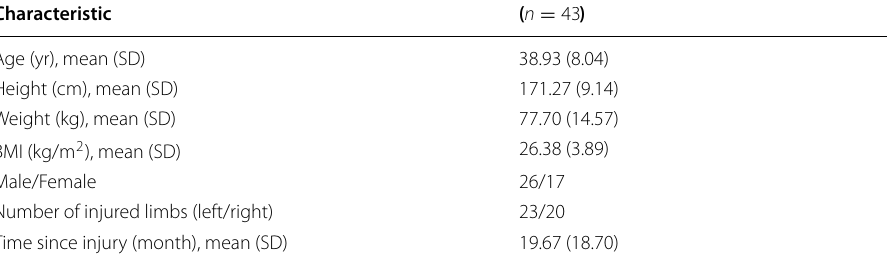
Table 1 Descriptive characteristics of the participated patients with unilateral ACL injury